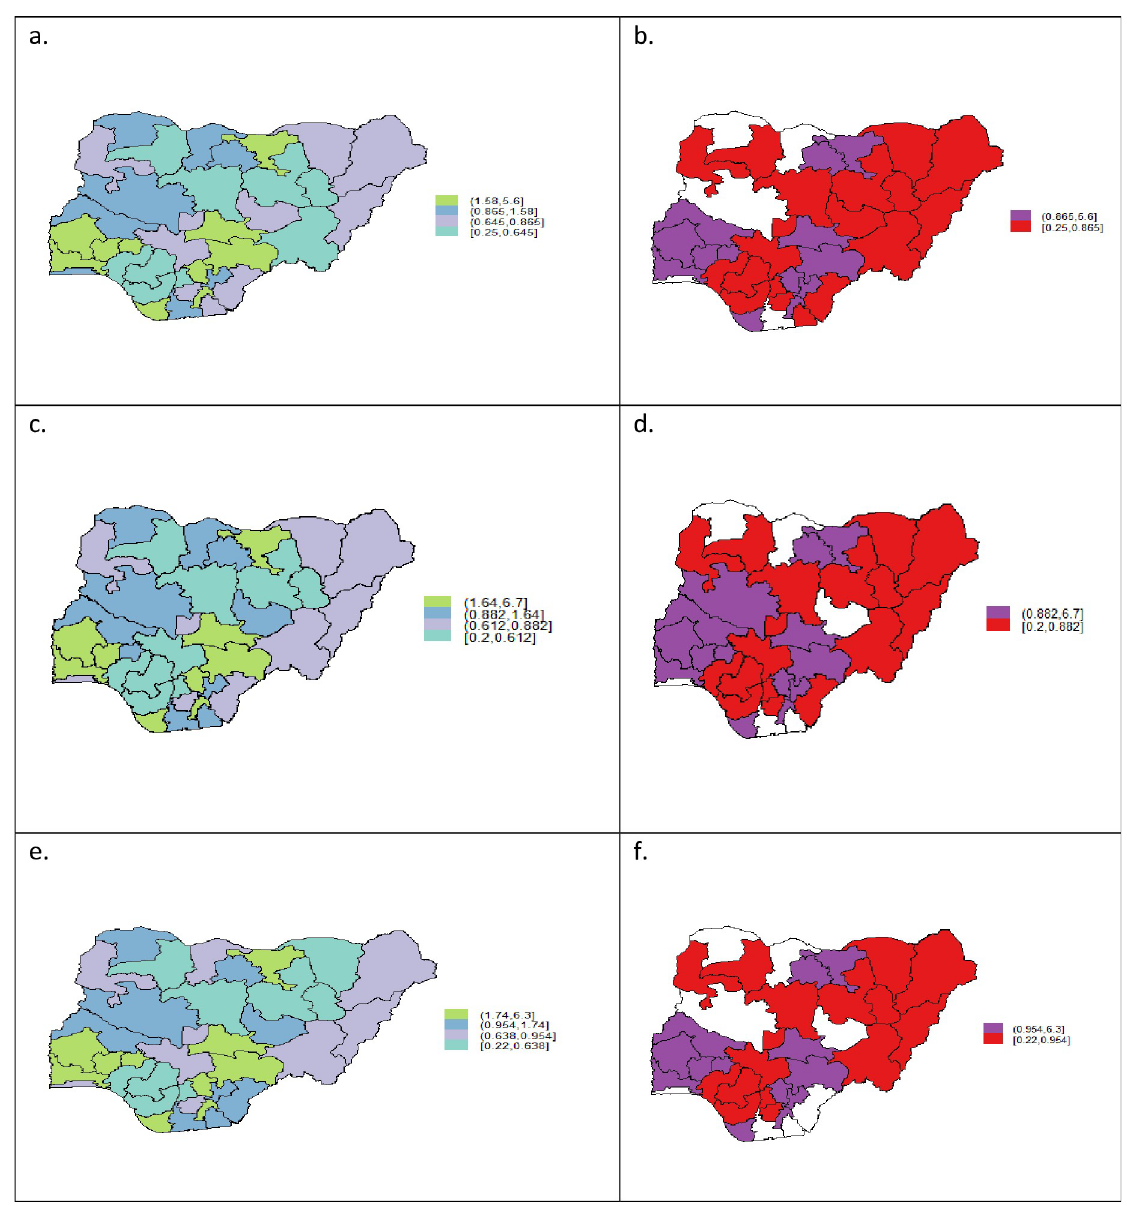
Fig 1. Estimated posterior mean spatial effects of Models (a) M1 and (b) its corresponding 95% posterior probability; (c) M3 for all women respondents and (d) its 95% posterior probability; and M3 for ever-married respondents and (f) its 95% posterior probability.